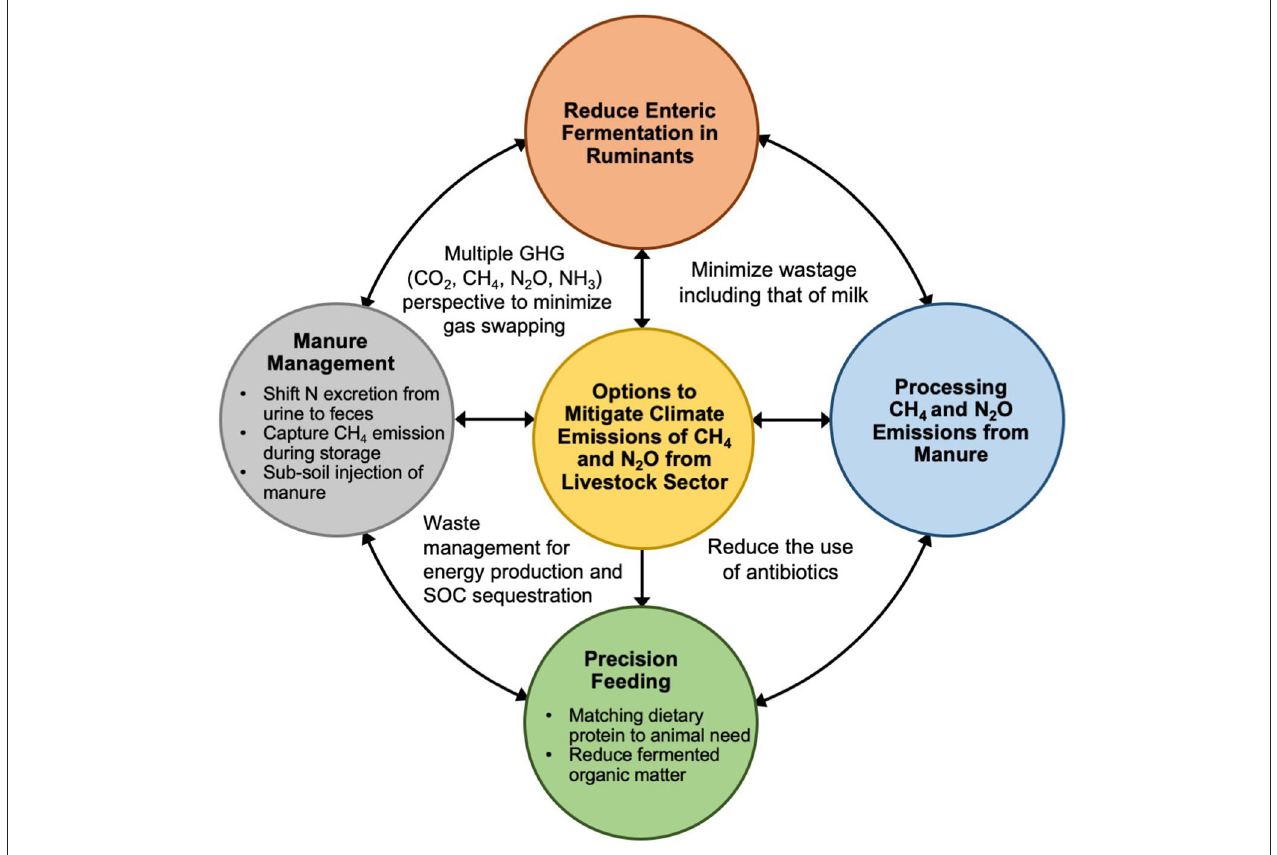
FIGURE 3 | Measures to reduce emissions of greenhouse gases (GHGs) from the livestock sector (SOC, soil organic carbon).